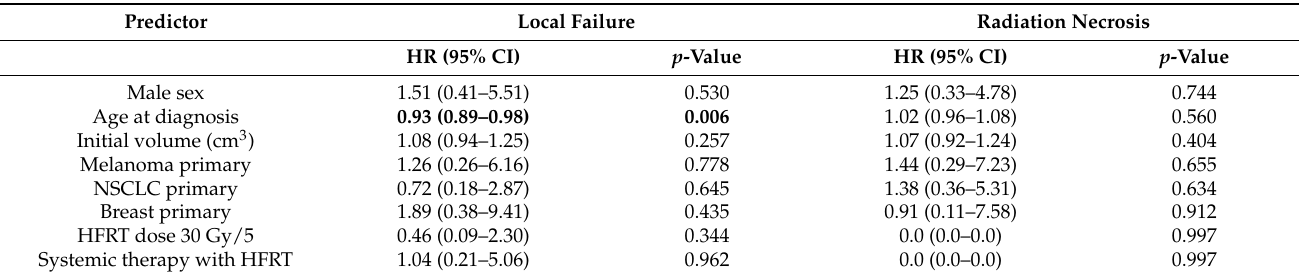
Table A2. Factors predictive of local failure and radiation necrosis on logistic regression. HFRT = hypofractionated radiotherapy, NSCLC = non-small cell lung